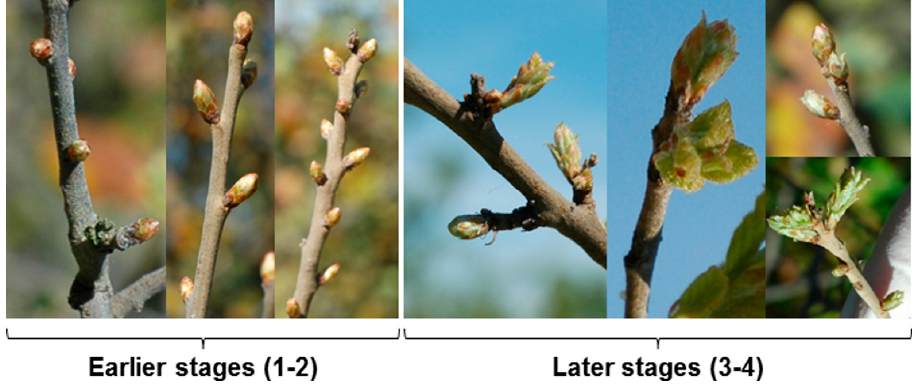
Figure 1. Development stages of bud sprouting in Quercus suber . Earlier stages: ( 1 ) dormant bud and ( 2 ) bud swollen. Later stages: ( 3 ) red bud and ( 4 ) open bud.